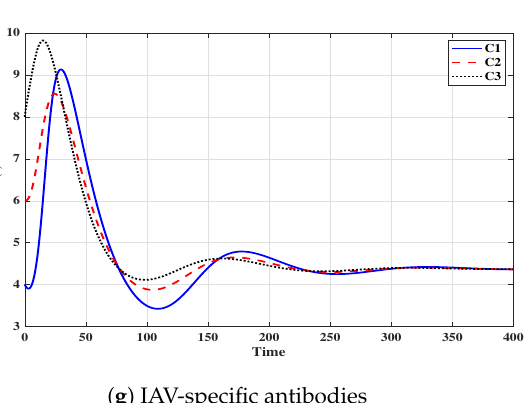
Figure 8. Solutions of system (3) with initials C1–C3 tend to Ξ 6 = ( 2.75,2.3,0.55,2.3,0.8,0,4.38 ) when (cid:60) 6 > 1, (cid:60) 2 / (cid:60) 1 > 1 and (cid:60) 8 ≤ 1 (Situation